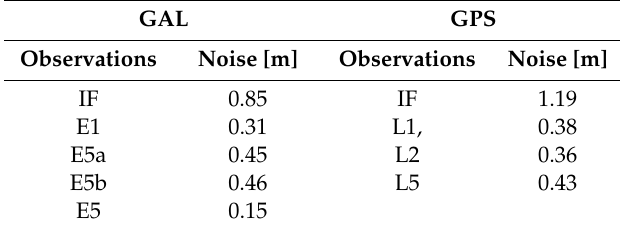
Table 4. RMS of code observation noises from the analysis of PPP post-fit residuals.